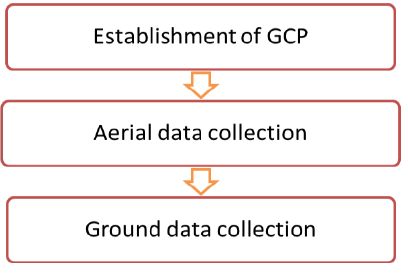
Figure 1 The flowchart in data acquisition phase